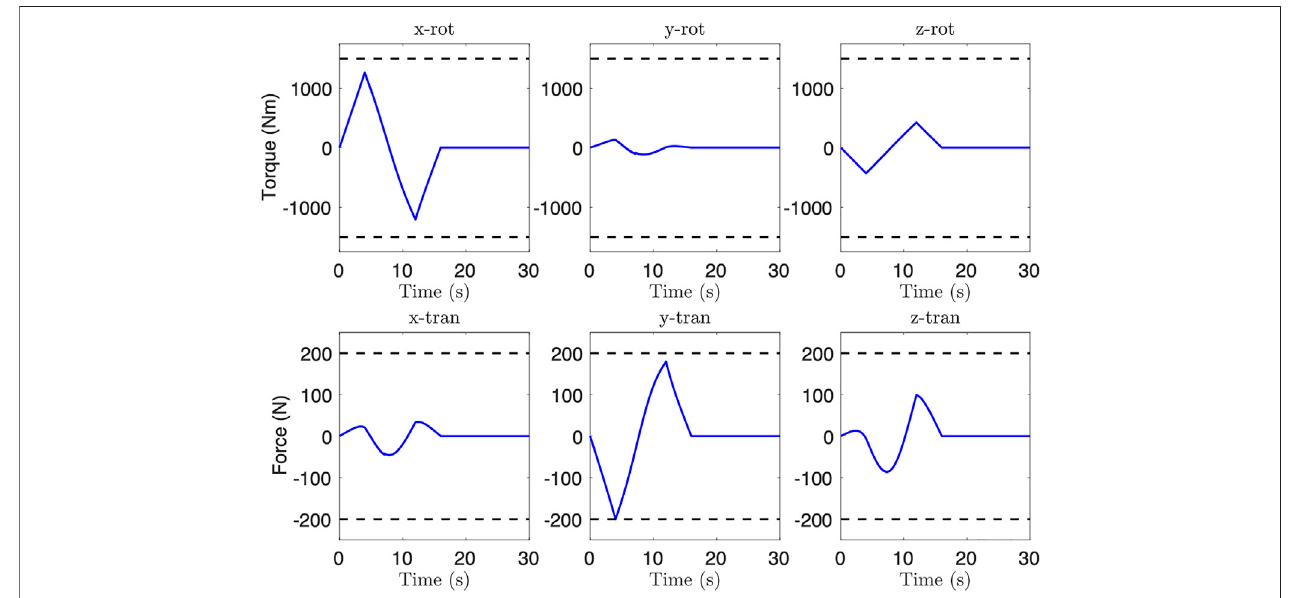
FIGURE 9 | Feedforward base actuation during controlled base trajectory after optimization. Note that the y -direction force reaches the speci fi ed limit.